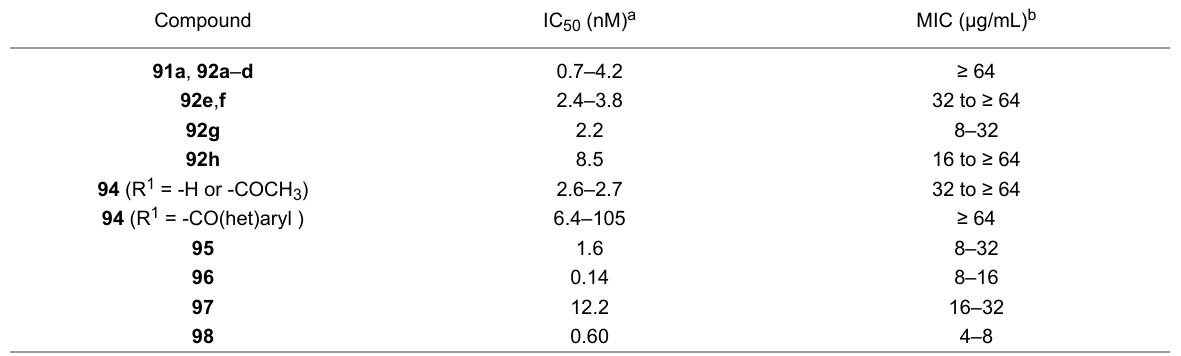
Table 3: Inhibitory (against MraY) and antibacterial activities of non-natural muraymycin analogues against Pseudomonas aeruginosa